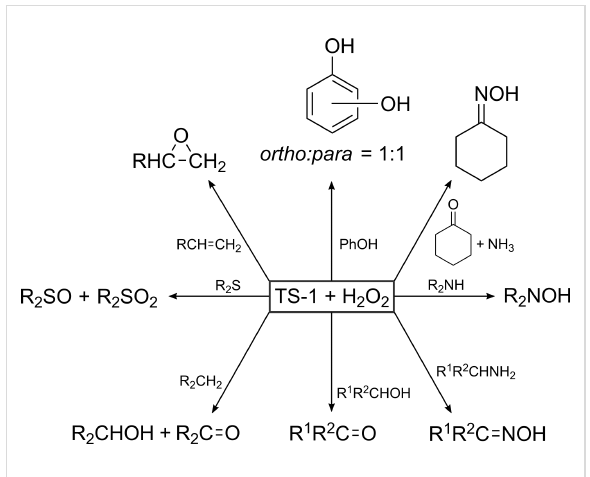
Figure 10: Schematic overview of the versatility of TS-1 as redox cata- lyst [172]. Reproduced with permission of Russian Chemical Reviews.